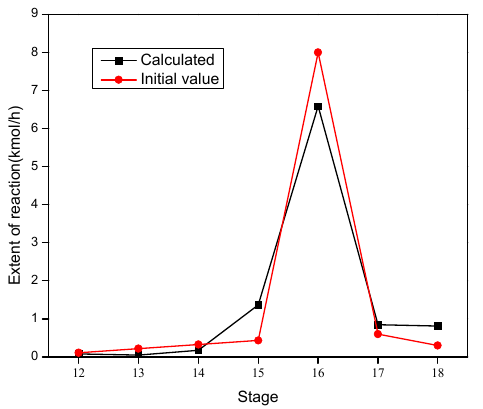
Figure 6. Comparison of the initial values of the extent of reaction and simulation results.